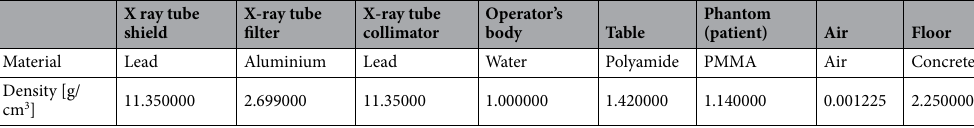
Table 2. MCNP6 materials assigned to the model.